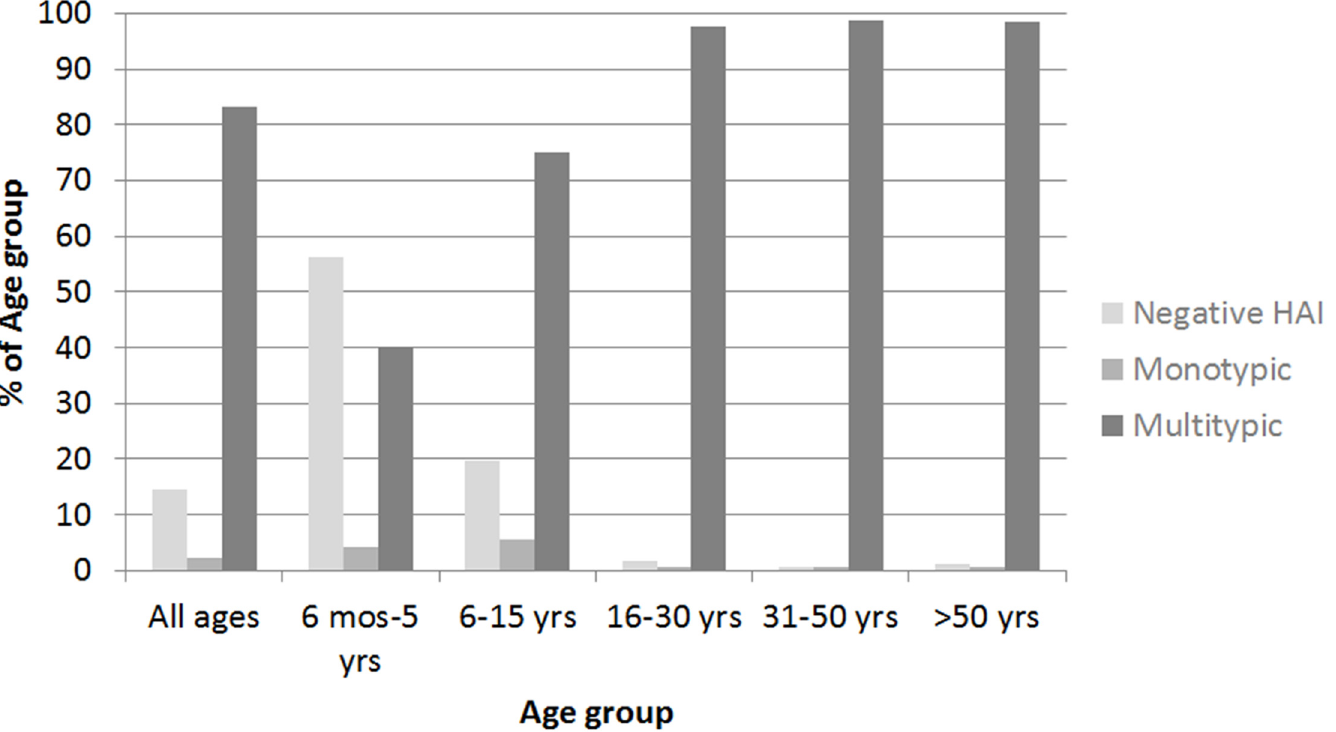
Fig 2. Dengue virus (DENV) hemagglutination inhibition (HAI) profiles at enrolment in different age groups.